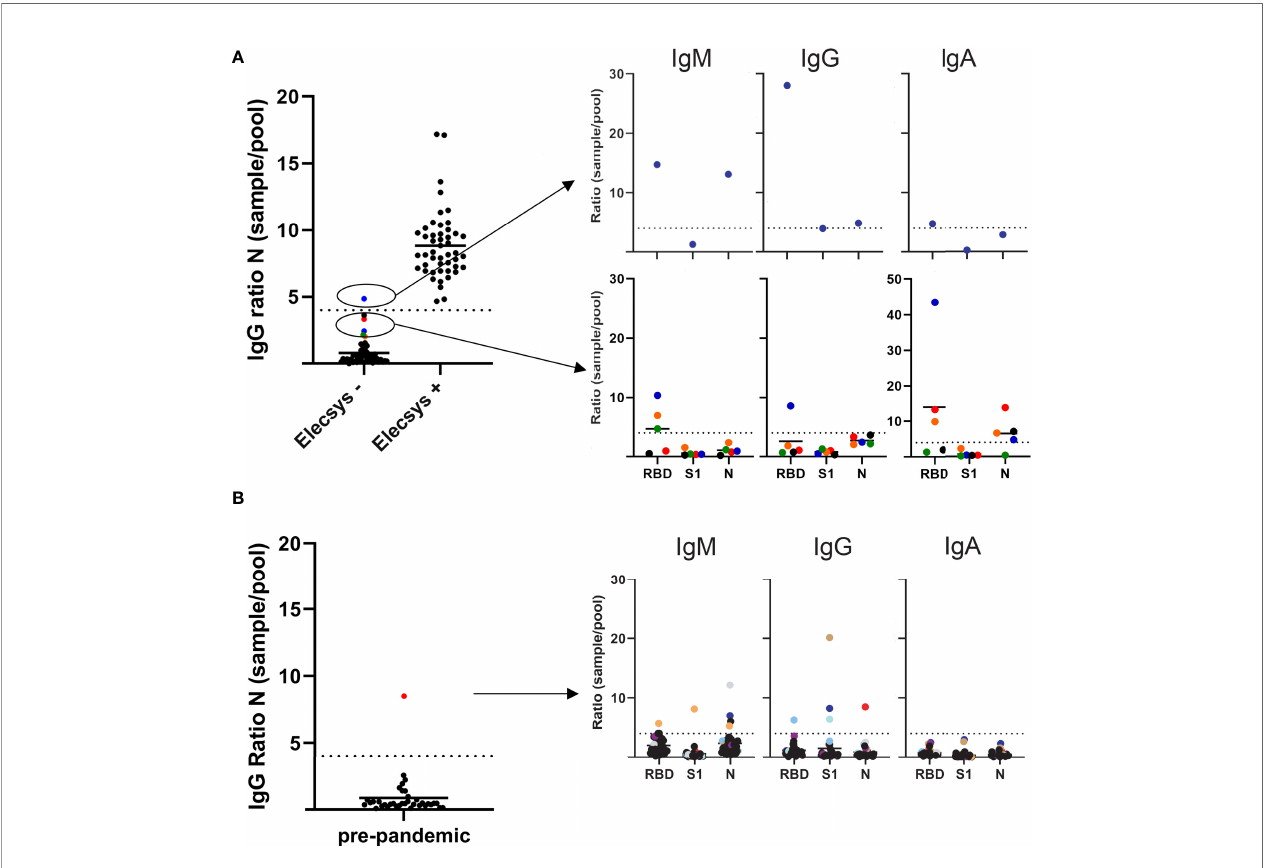
FIGURE 1 | SARS-CoV-2 antibody levels as measured by a multiplex based assay and calibrated against the Elecsys ® Anti-SARS-CoV-2 assay (Roche diagnostics). (A) 100 serum samples previously analyzed by Elecsys ® assay (depicted on the x axis as negative and positive), were received from the Department of Clinical Microbiology, and SARS-CoV-2 IgG antibodies against the N protein were analyzed blindly by multiplex (left panel). Right top panel depicts the single sample that had a SARS-CoV-2 IgG >4 sample/pool ratio for the N protein. Bottom right panel depicts the samples that showed a >2 but <4 than 4 sample/pool ratio by multiplex. (B) Left panel depicts 36 serum samples received in 2019 by the Department of Immunology. SARS-CoV-2 IgG antibodies against the N protein were analyzed by multiplex. Right panel depicts the serum/pool ratio of the serum samples against RBD, S1 and N proteins. Samples above the cut-off level are color